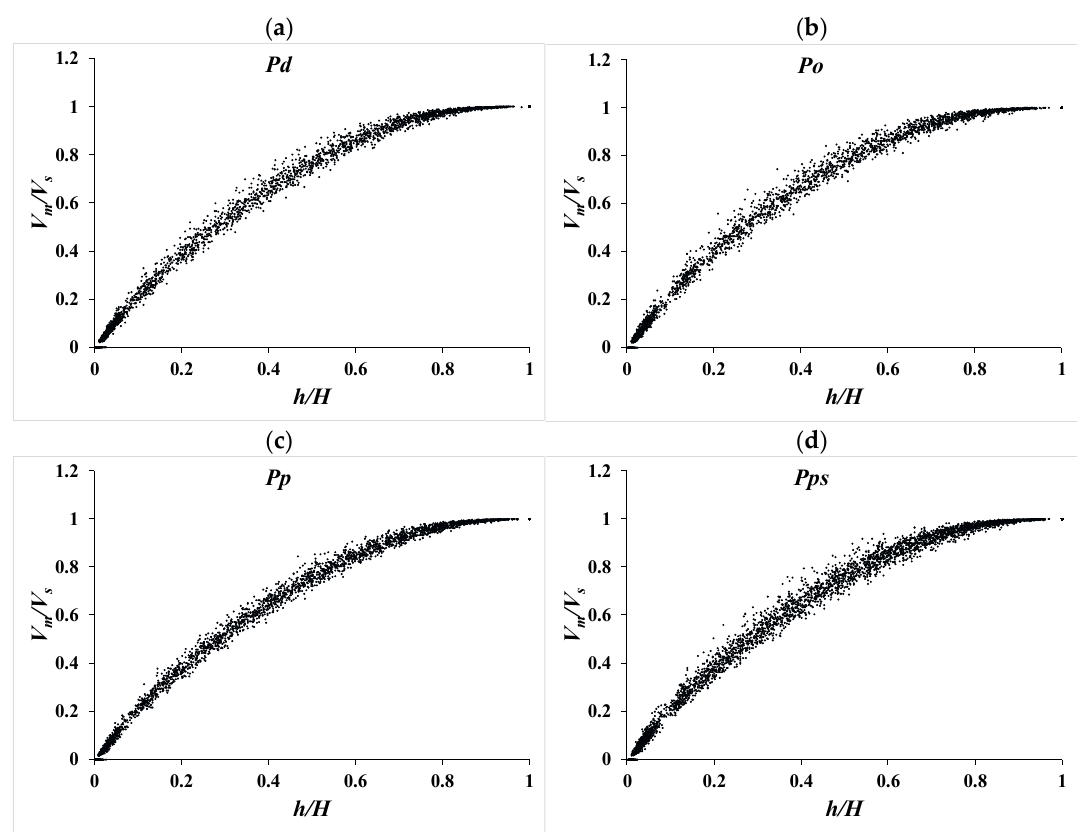
Figure 2. Relative volume ( V m / V s ) and relative height (h/H) for Pinus douglasiana (Pd; a ); Pinus oaxacana (Po; b ); Pinus patula (Pp; c ); and Pinus pseudostrobus (Pps; d